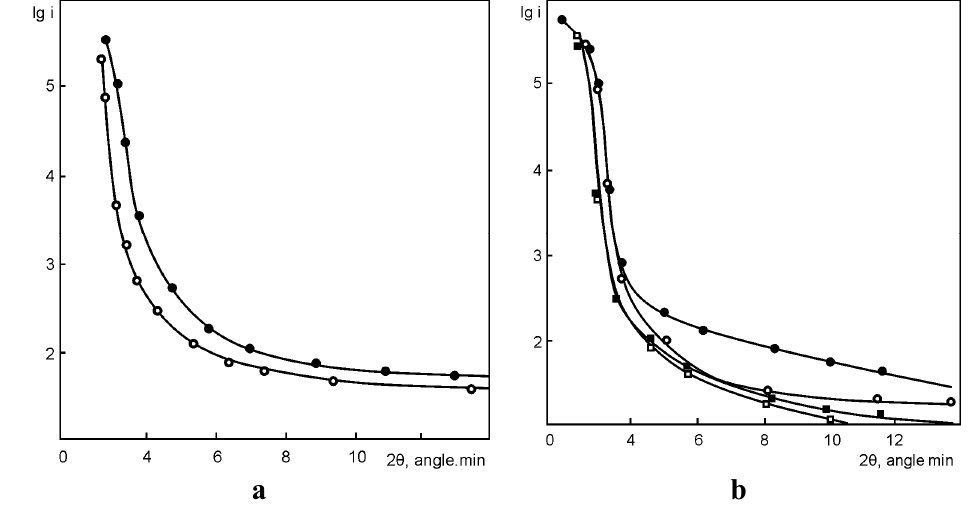
Figure 3. SAXS indicatrixes for thin ( h = 0.03–0.25 mkm) Cu coatings precipitated under Earth-based ( a ) and space ( b ) conditions. ( a ) immobile ( 1 ) and mobile ( 2 ) substrates, h = 0.175–0.250 mkm; ( b ) immobile substrate: ● , h = 0.175 mkm; ○ , 0.08 mkm; ■ , 0.05 mkm; ◊ , 0.03